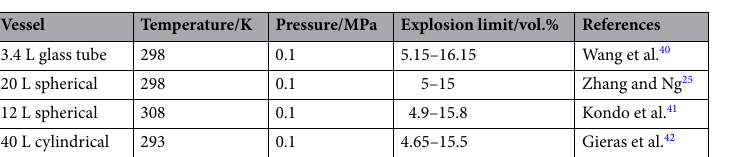
Table 2. Explosion limit for methane in air at different initial conditions.